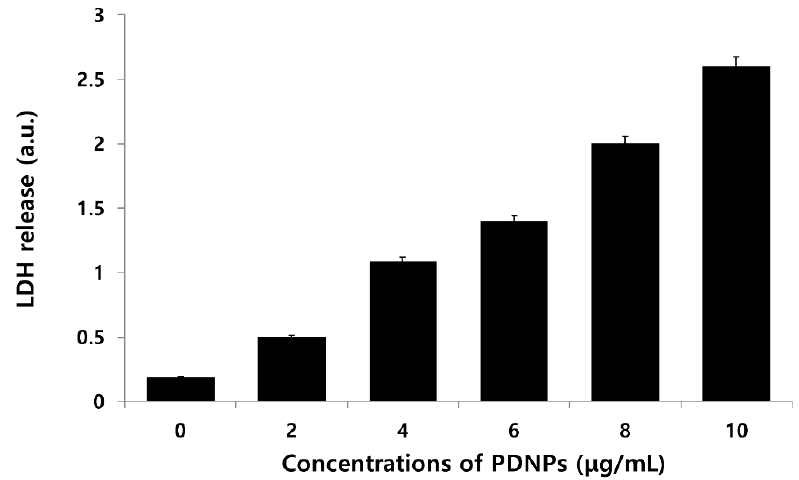
Figure 8 . Effect of palladium nanoparticles (PdNPs) on leakage of lactate dehydrogenase (LDH). LDH activity was measured at 490 nm using an LDH cytotoxicity kit. Results are mean ± standard deviation (SD) of three independent experiments. Significant difference in LDH activity of PdNPs compared to untreated cells was evident using Student’s t -test, p < 0.05.